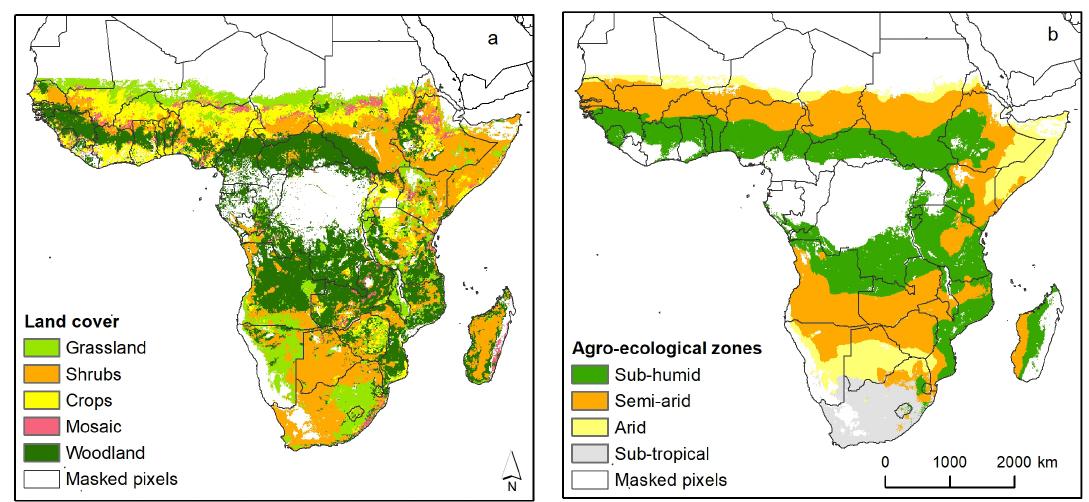
Figure 1. ( a ) Land cover map for the year 2000 derived from the European Space Agency’s Climate Change Initiative (ESA CCI) product; ( b ) The agro-ecological climatic zones of the United Nations’ Food and Agriculture Organization